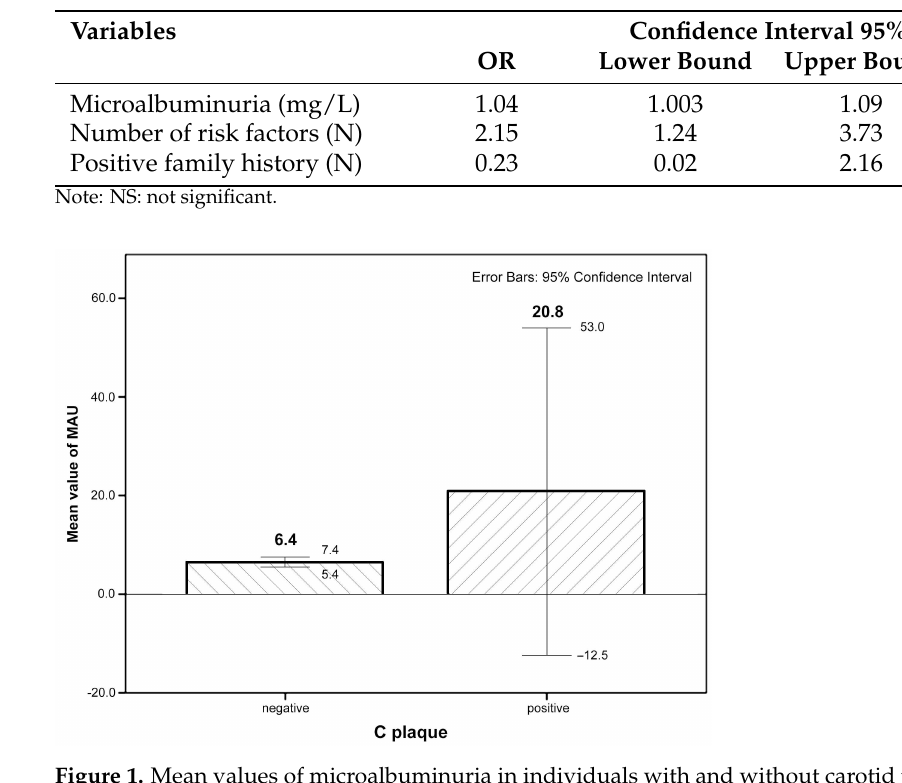
Table 7. Final multivariate binary logistic regression model from statistically significant predictors of carotid plaque (N = 9). Odds ratio (OR) and 95% confidence interval. Significant variables were entered into a multivariate model which was then run through a backwards eliminating procedure where only mutually adjusted and still significant variables remained.